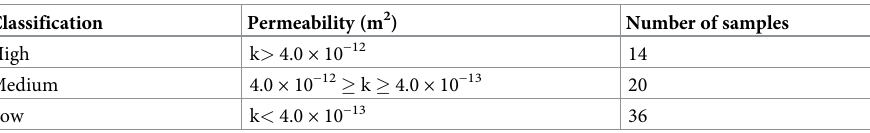
Table 1. Soil gas permeability classifications